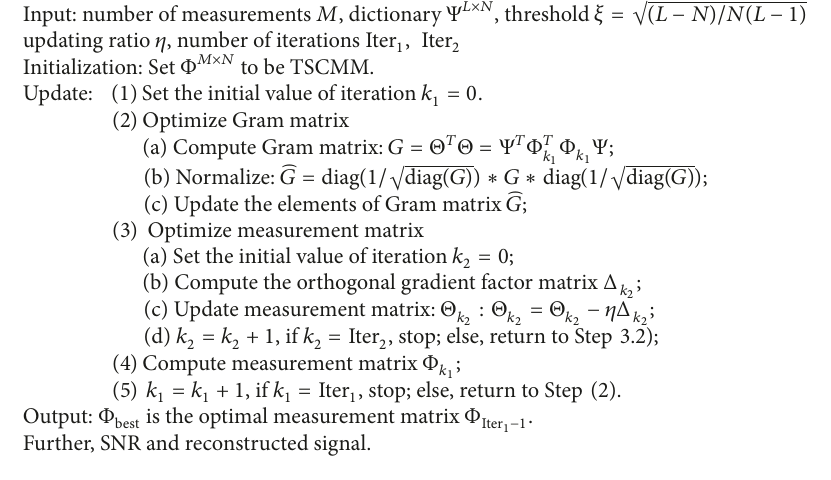
Algorithm 1: The flow diagram of the proposed method. Optimization of